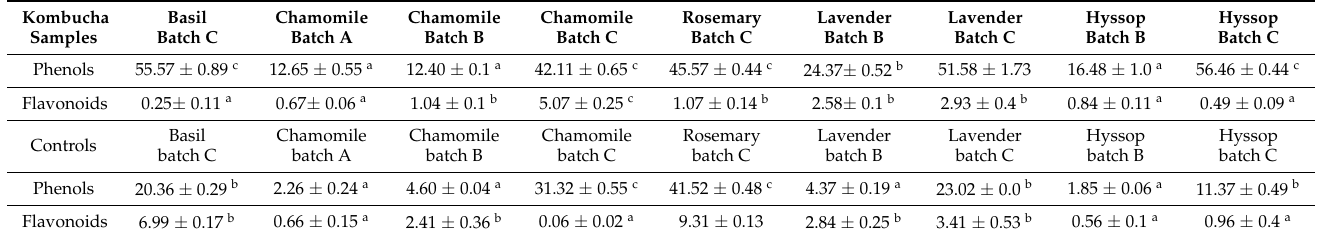
Table 3. Phenols content (mg GA/100 mL) and flavonoid content (mg RU/100 mL).